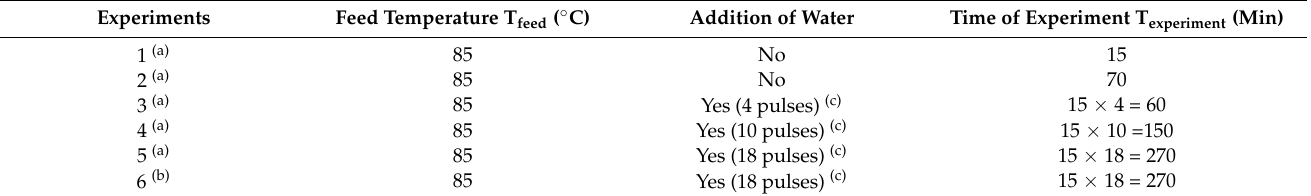
Table 3. Operating conditions showing the operating values used during the vacuum distillation- fractionated condensation experiments.